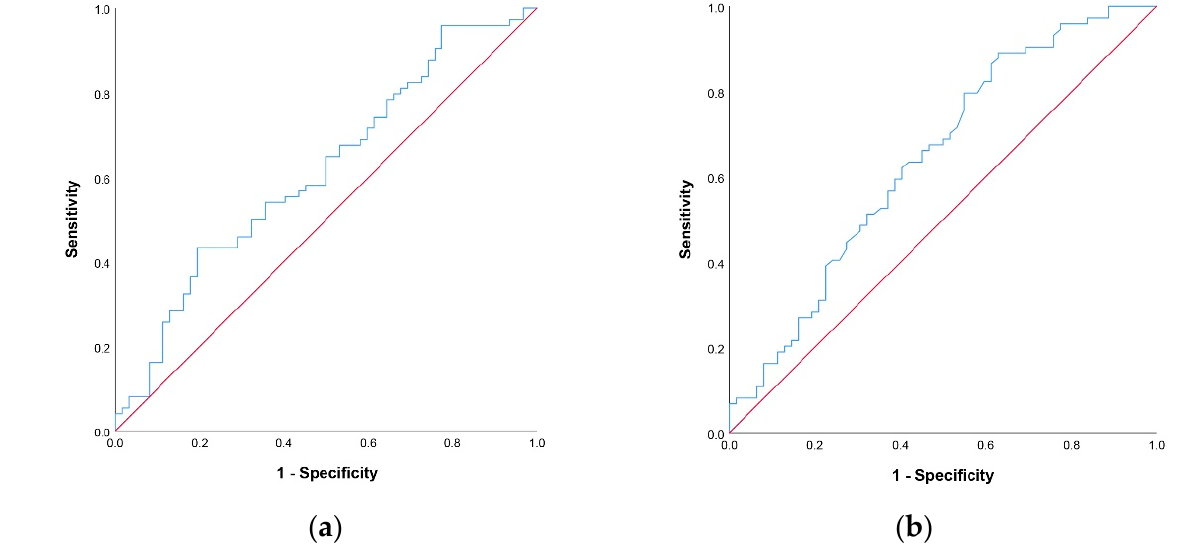
Figure 1. ROC curve for NLR ( a ) and PNI ( b ).